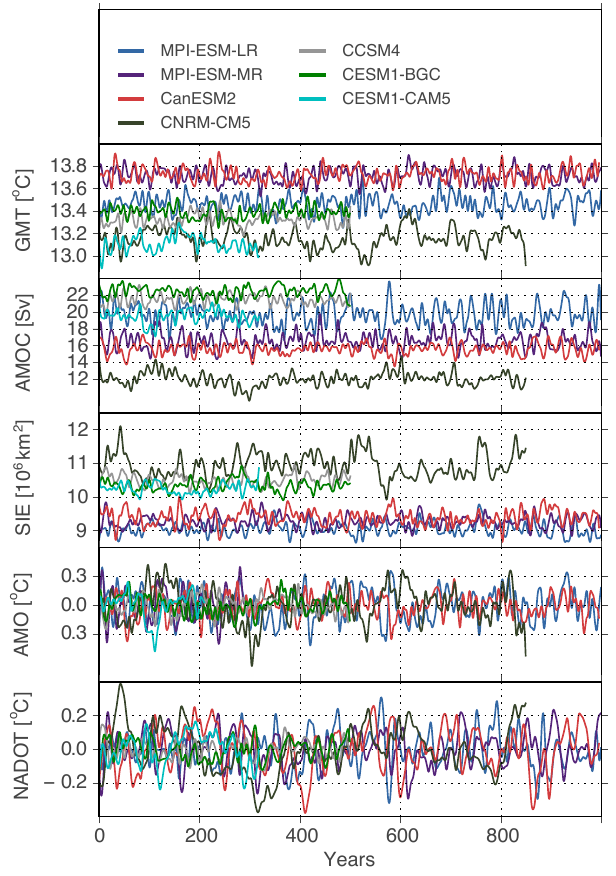
Fig. 1. Time series for GMT, AMOC, Northern Hemisphere Sea-Ice Extent (SIE), the Atlantic multi-decadal oscillation (AMO) index and North Atlantic deep-ocean (NADO) temperature for seven CMIP5 models. A 10 yr butterworth low-pass filter is applied to the time series.